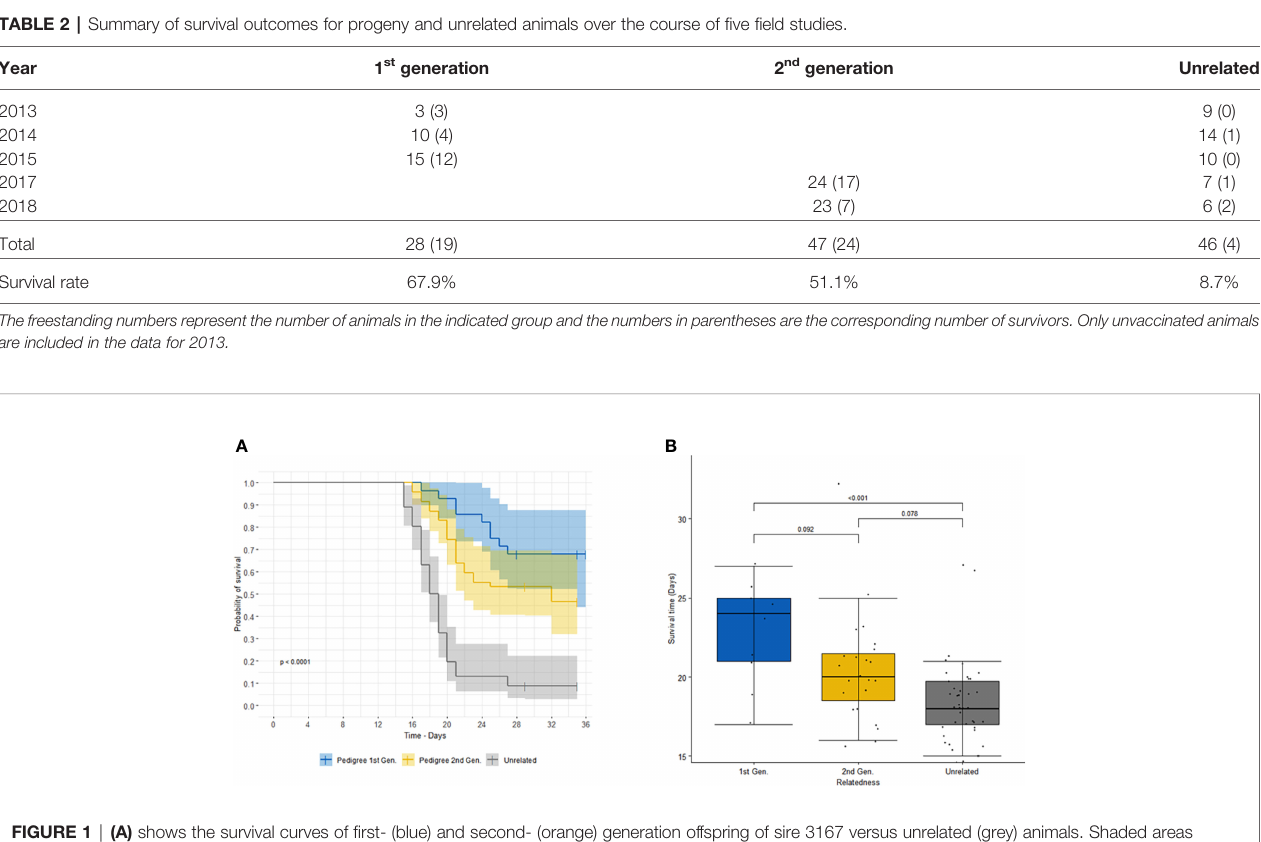
FIGURE 1 | (A) shows the survival curves of fi rst- (blue) and second- (orange) generation offspring of sire 3167 versus unrelated (grey) animals. Shaded areas correspond to 95% con fi dence intervals. (B) shows the comparison of survival time (or time to death) of animals that succumbed to infection for fi rst- (blue) and second- (orange) generation offspring of sire 3167 and unrelated (grey) animals. The p-values for the speci fi c paired comparisons from the linear regression (adjusted for multiple comparisons using Tukey) are shown above the